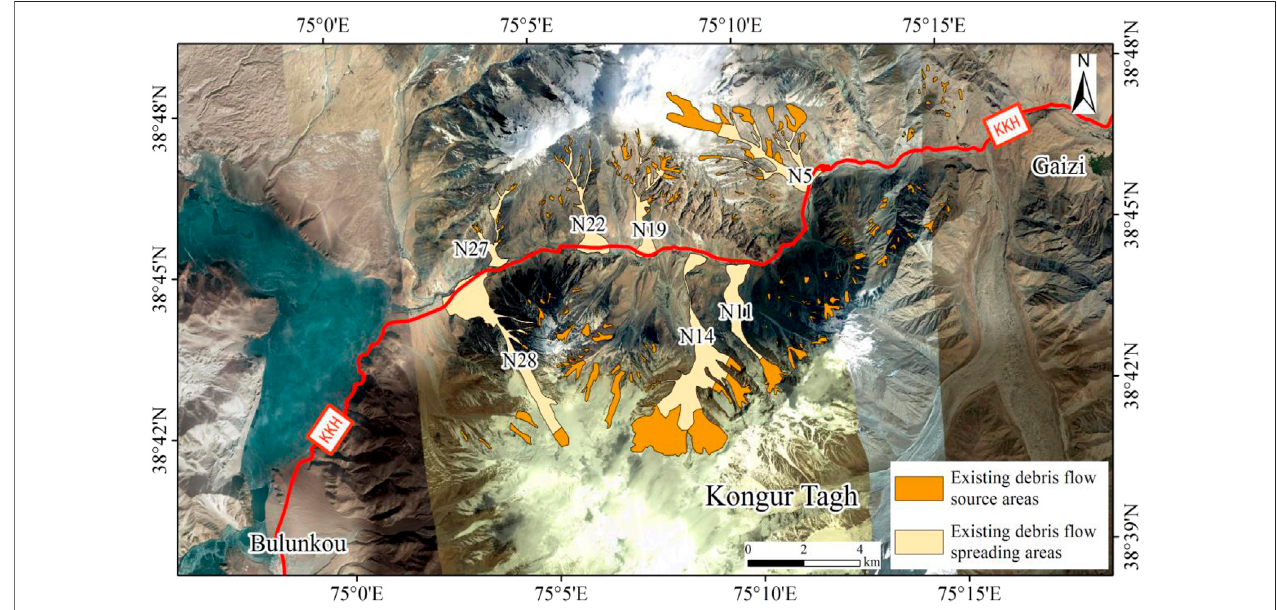
FIGURE 3 | Hazards inventory map of the study area was obtained by satellite photographs